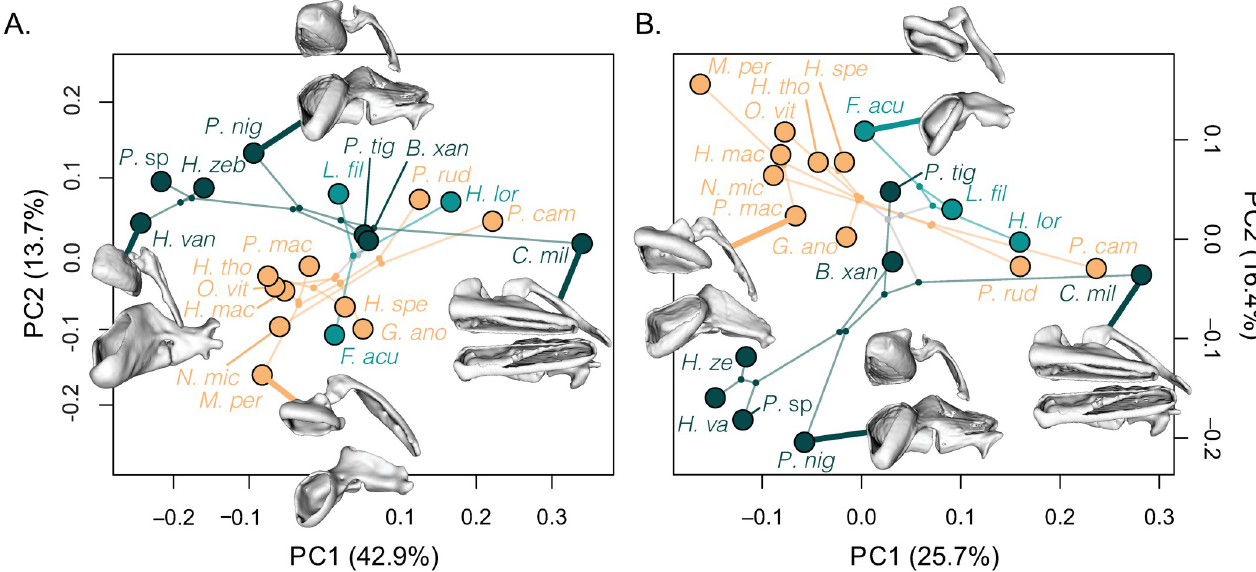
Fig 3. Phylomorphospaces for the combined shape (premaxilla, maxilla, and lower jaw) for loricariid species using (A) traditional and (B) automated landmarking. Subfamilies denoted by colors; Hypoptopomatinae in orange, Hypostominae in dark green, and Loricariinae in light green. See Table 1 for abbreviations of